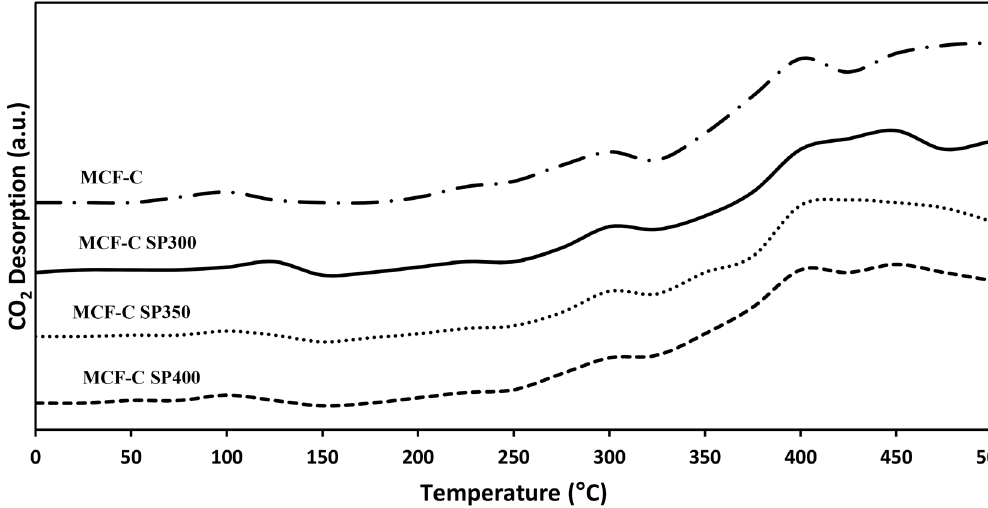
Figure 7. TPD-CO2 profile of the fresh and spent catalysts.